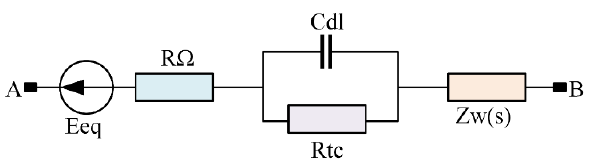
Figure 44. Equivalent circuit of the Ni-MH battery. 𝐸 𝑒𝑞 is the equilibrium voltage of the cell, and 𝒁 𝒘 is the Warburg impedance representing the diffusion phenomena at low frequencies, τ = 𝑅 𝑡𝑐 𝐶 𝑑𝑙 is the time constant-relative to the charge transfer phenomena [139,140].